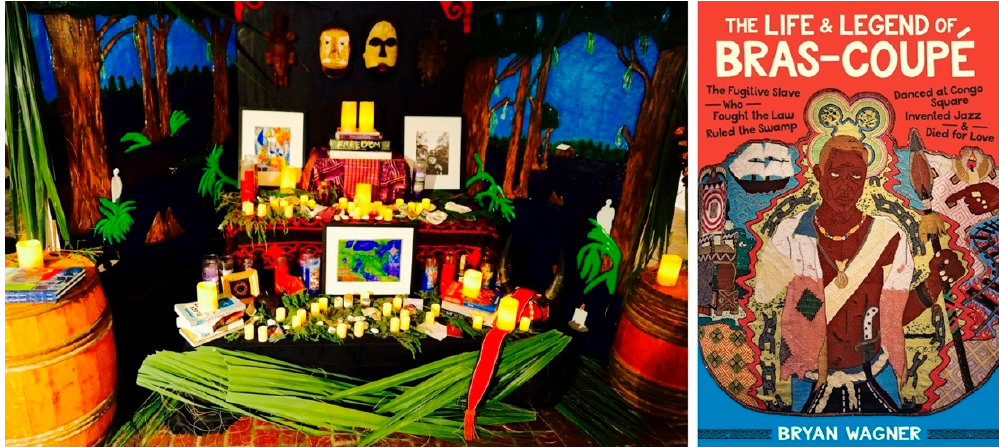
Figure 3. ( Left ): An altar dedicated to the memory of Juan San Malo, a maroon leader in south Louisiana in the 1780s, and other freedom seekers around the world, on display at the Louisiana State Museum’s Arsenal #1 at the Cabildo on Jackson Square as part of the Neighborhood Story Project’s exhibit Le Kèr Creole (The Creole Heart): Runaway Slaves, Music, and Memory in Louisiana in 2019. Photograph by Bruce Sunpie Barnes. ( Right ): On the Neighborhood Story Project’s altar is a copy of Bryan Wagner’s book dedicated to the history and legend of Bras-Coupé, an enslaved man who escaped bondage in the 1830s (Wagner 2019). The artwork on the cover is a beaded portrait of Bras-Coupé by Demond Melancon, Big Chief of the Young Seminole Hunters. Photograph courtesy of Bryan Wagner.